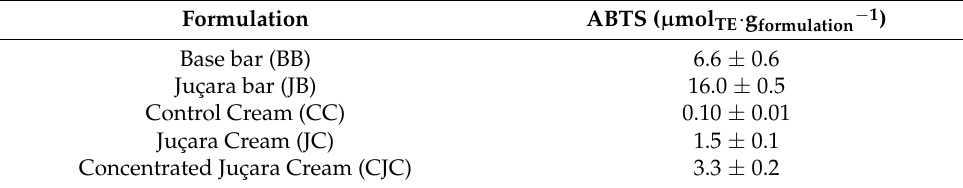
Table 4. Antioxidant activity by the ABTS method for soap bar and cream